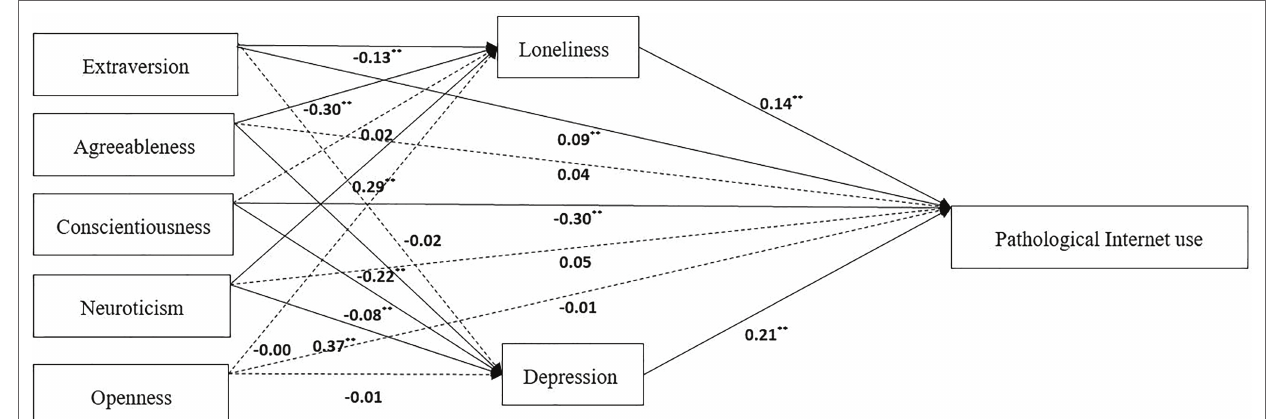
FIGURE 2 | Theoretical model. **p < 0.01.